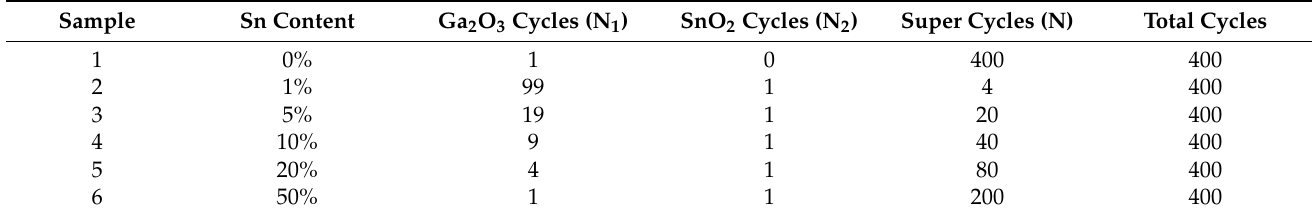
Figure 1. The schematic diagram for the ALD super cycle of the Sn ‐ doped Ga 2 O 3 film growth. Table 1. Deposition parameters for the Ga 2 O 3 samples with various contents of Sn.